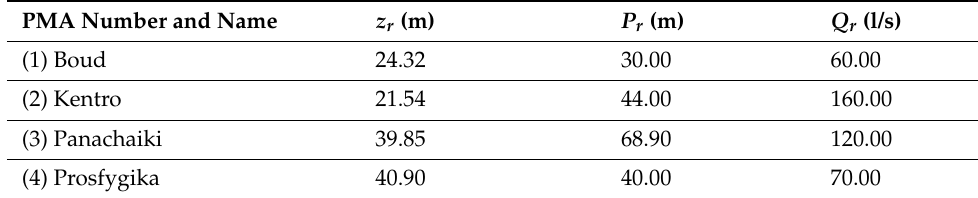
Table 3. Inlet point elevation ( z r ), applied pressure ( P r ), and hourly maximum water consumption ( Q r ) for each of the four PMAs studied. The corresponding Q r estimates have been obtained using the available flow-pressure time series at the PMA inlets, during the eight-month-long high consump- tion period of the year from 1 March 2019 to 31 October 2019. Numbers indicate the locations of PMAs in Figure